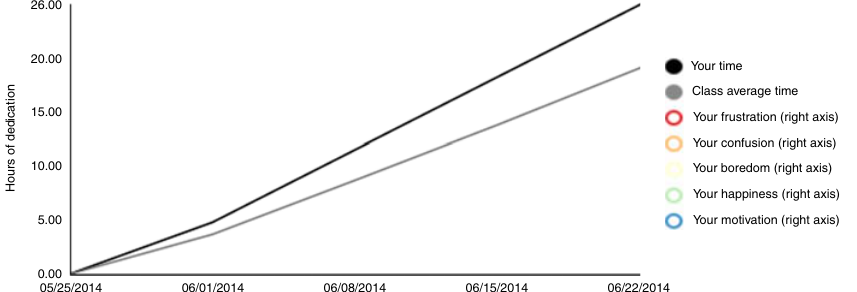
Figure 2. Timeline visualization of the accumulated amount of time dedication and the frequency of affective